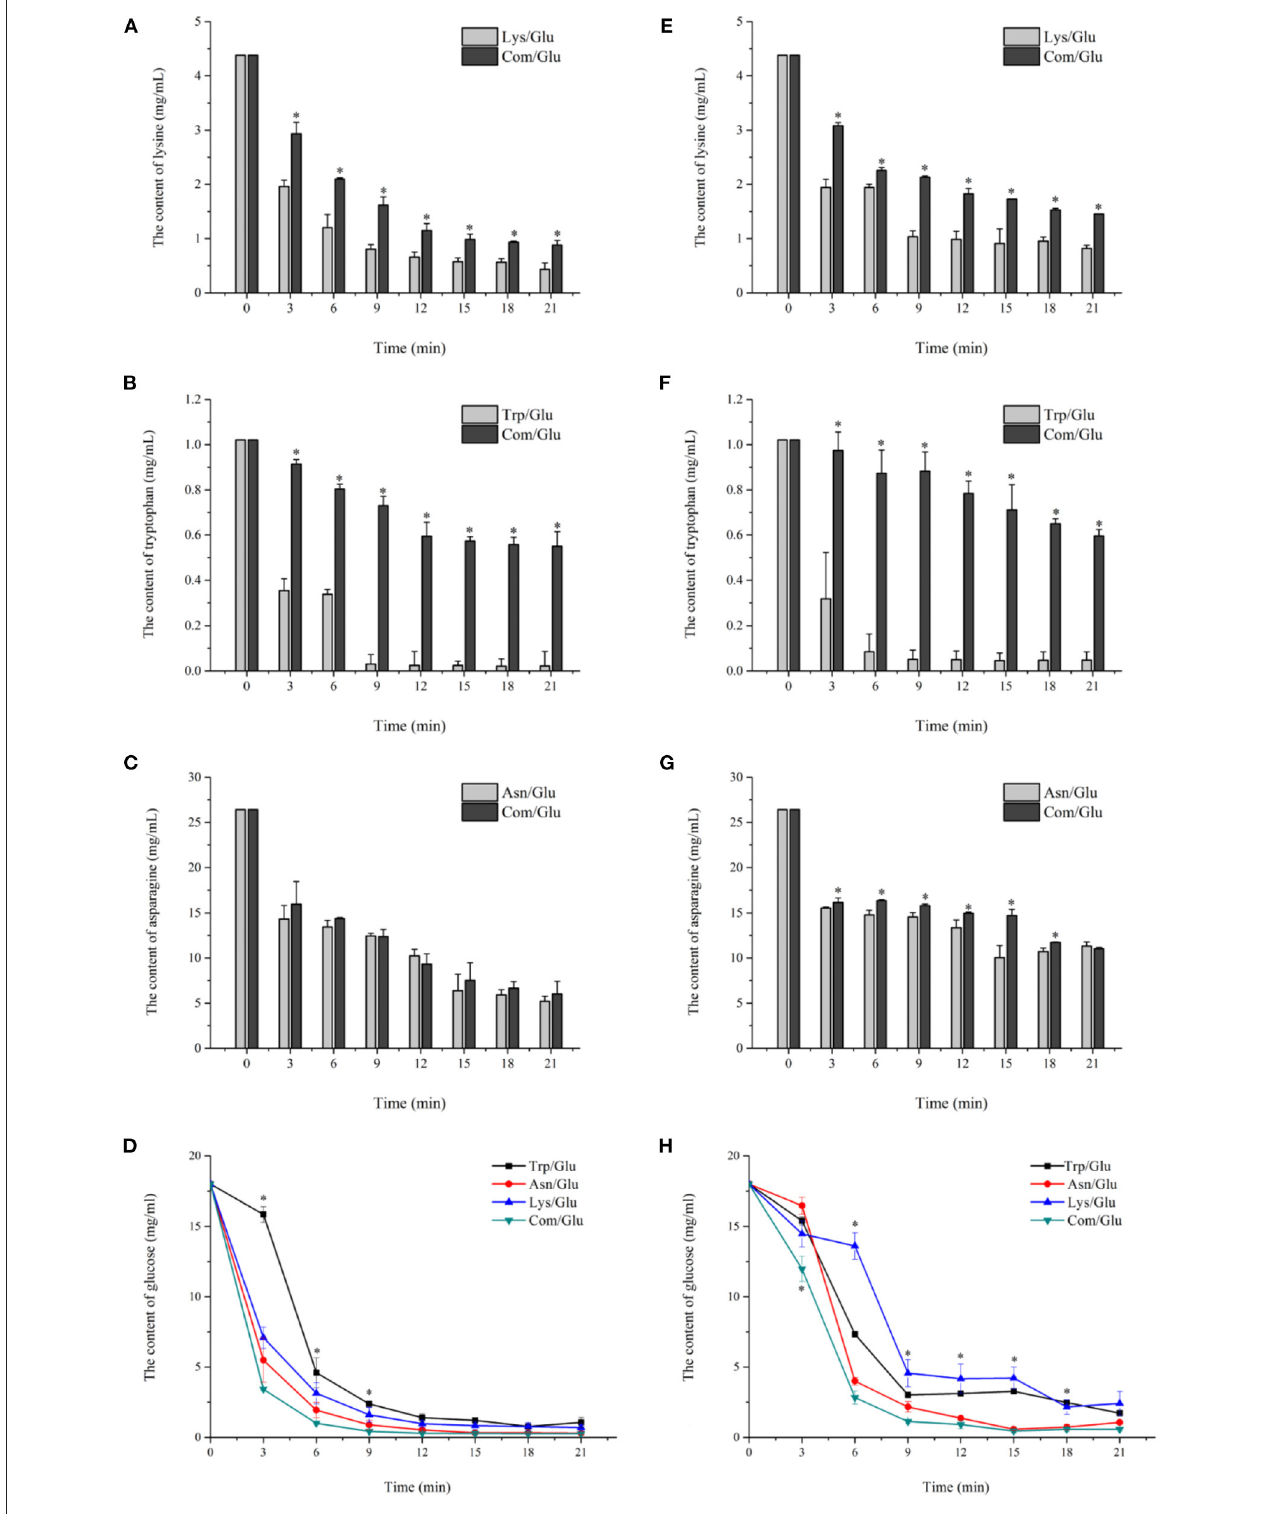
FIGURE 2 | Kinetic profiles of Lys (A,E) , Trp (B,F) , Asn (C,G) , and glucose (D,H) in the different amino acid/glucose model system heated at 170 ◦ C (A–D) and 200 ◦ C (E–H) . Data were expressed as mean ± SD in triplicates ( n = 3), *, ( P < 0.05).